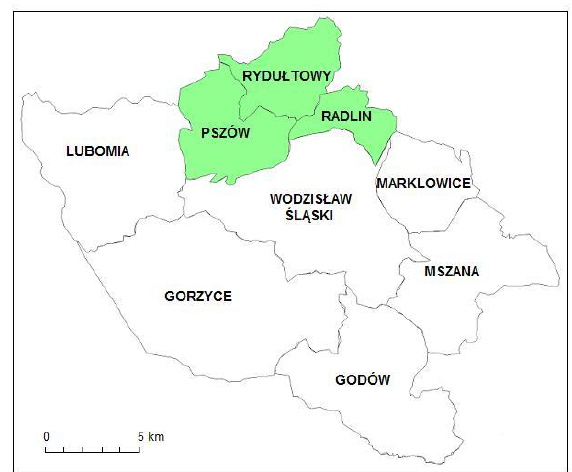
Fig. 3. Areas with good conditions to geoturism development in Wodzisław district (own